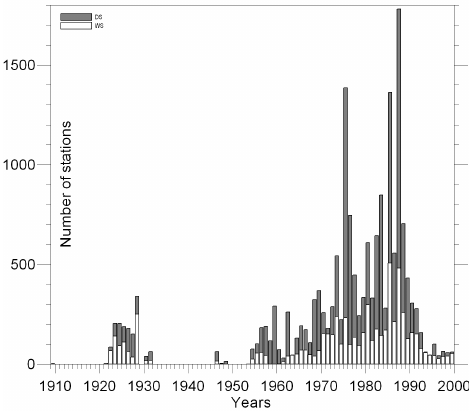
Fig. 3. The bar-chart showing distribution of the number of obser- vations over calendar months (1=January). Open parts of the bars represent measurements taken on the